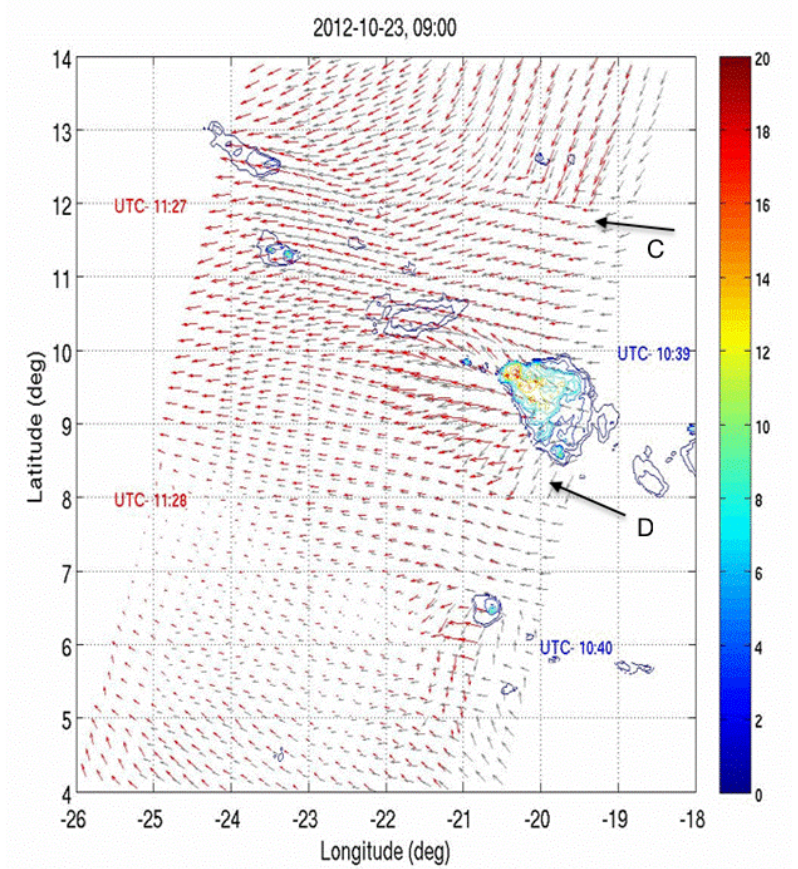
Figure 2. A satellite view of interaction of rain and ocean winds in Atlantic Inter-Tropical Convergence Zone in an area a few degrees north of equator to west of coast of Africa. Figure shows superposition of wind vectors from ASCAT-A (black) and ASCAT-B (red) with contours of Meteosat Second Generation (MSG) rain at time corresponding to pass of ASCAT-A. Colorbar shows rain rate in mm h − 1 . Note convective rain cells ( > 10mm h − 1 ) and nearby areas of strong wind convergence (C) and divergence